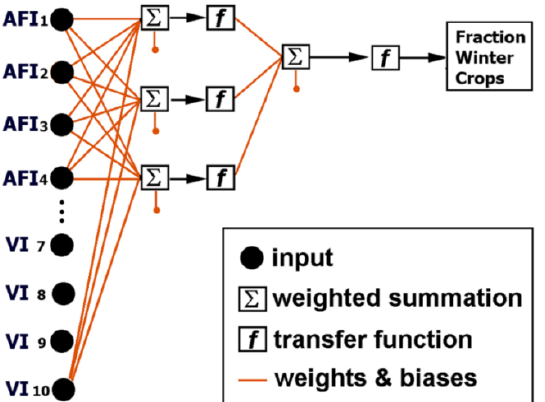
Figure 5. Principle functioning of a three-layer neural net as used for the current study. In the illustration, eight input nodes are shown representing four fractional land cover classes to AFI ) and four vegetation index values (VI to VI ). The hidden layer consists of (AFI 1 4 7 10 three nodes receiving weighted inputs from the input nodes. The output node (target) outputs the fractional winter crop coverage for the provided input. After calculation of the weighted sums, the resulting values are passed through a (tan-sigmoid) transfer function. Weights and biases are optimized during the training by presenting the net with samples of input and target values and minimizing the error between reference and simulated target value. The current study used a very similar net with, however, twenty-one input nodes (five broad land cover classes plus 16 vegetation index